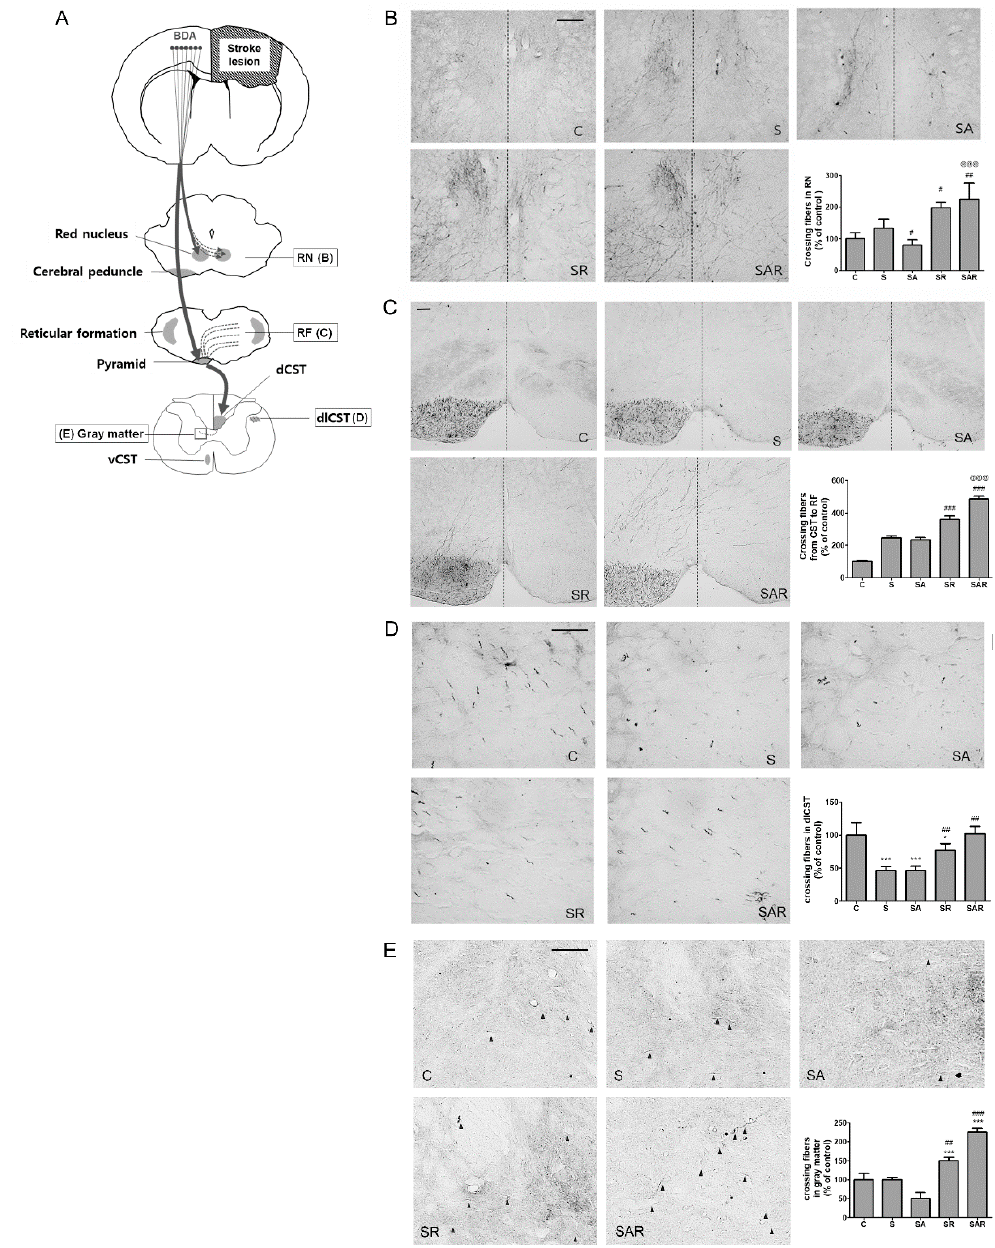
Figure 6. Task-specific training (TST) and TST combined with 5-Aza-C treatment promote contralesional CST plasticity in chronic stroke. ( A ) Schematic illustration of CST including contralesional red nucleus (RN), reticular formation (RF) in medullar oblongata, dorsolateral spinal tract (dlCST) and ipsilesional gray matter in the spinal cord. Solid square boxes indicate analysis area for CST plasticity in this study; ( B – E ) photomicrographs of BDA staining in the contralesional RN, RF in medullar oblongata, dlCST and ipsilesional gray matter in spinal cord sections. ( B , C ) Broken lines in RN and RF indicate the midline of the midbrain; ( E ) midline-crossing fibers indicate black arrowheads. dCST: dorsal CST; dlCST: dorsolateral CST; vCST: ventral CST. Scale bars = 50 μ m. Mean density of BDA-positive axonal crossing fibers in the RN ( B ), RF ( C ), dlCST ( D ), and gray matter of spinal cord ( E ) shown as% increase of sham control ( C ). Results are presented as the mean ± SEM in the graphs. n = 6. Significance is indicated by * p < 0.05; *** p < 0.001 vs. sham control (C), # p < 0.05; ## p <0.01; ### p < 0.001 vs. Stroke (S), @@@ p < 0.001 vs. SR.